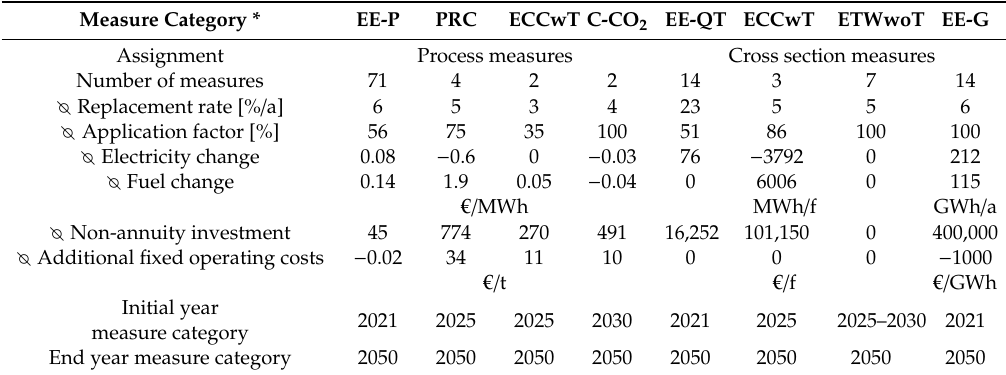
Table 2. Characteristic parameters and values by measure category in